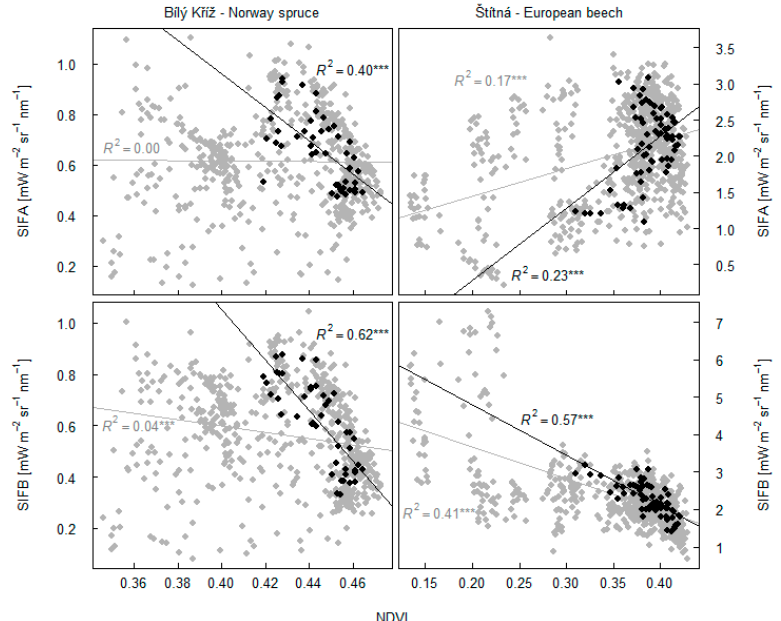
Figure 10. Dependency of fluorescence emission in O 2 A band (SIFA) and O 2 B band (SIFB) on NDVI of the spruce and beech forests. Black points refer to fluorescence and NDVI data in time intervals with significant relationship between fluorescence emission and NDVI. These points refer to data measured in the summer period, N = 46 for spruce data set and N = 68 for beech data set. Grey points show relationships between data in 30 min intervals, and relationships refer to time intervals shown in Figure 9. The asterisk *** indicates statistically significant result at p < 0.001.